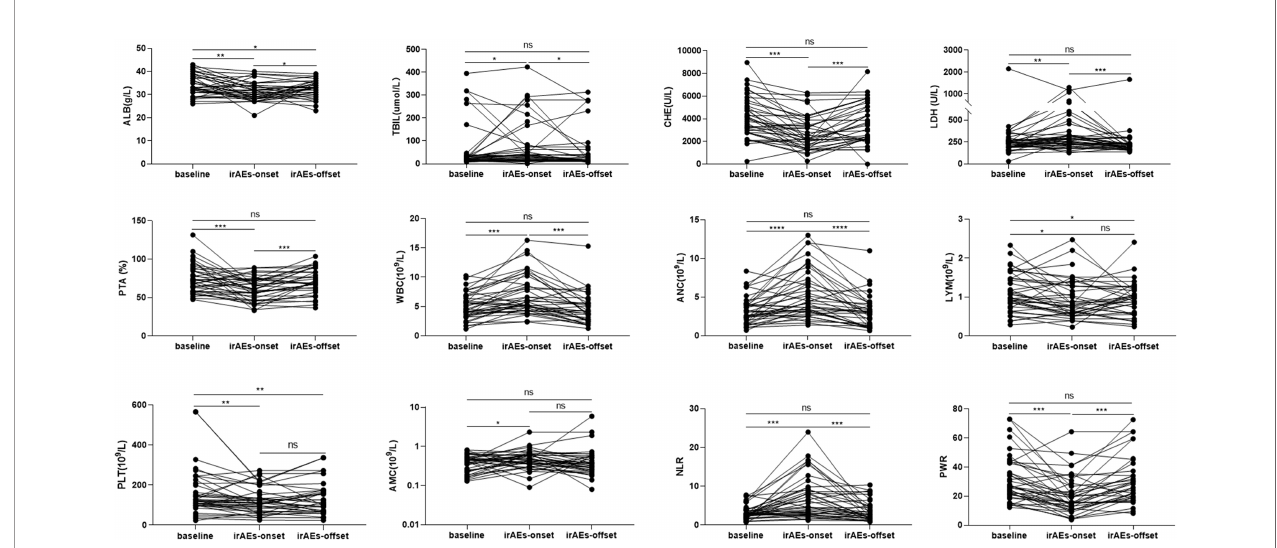
FIGURE 3 | Comparison of the laboratory results at baseline, immune-related adverse event (irAE)- onset, and irAEs-offset in patients with irAEs. ALB, albumin; TBIL, total bilirubin; CHE, cholinesterase; LDH, lactate dehydrogenase; PTA, prothrombin activity; WBC, white blood cell; ANC, absolute neutrophil count; AMC,